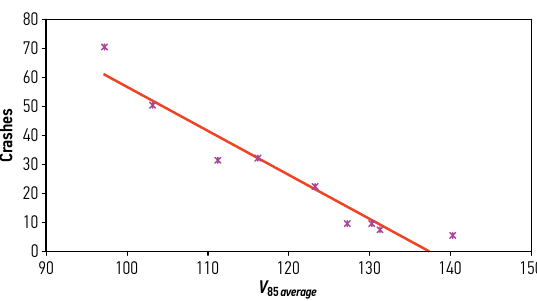
Number of Groups Fig. 3. Crashes related to tortuousness